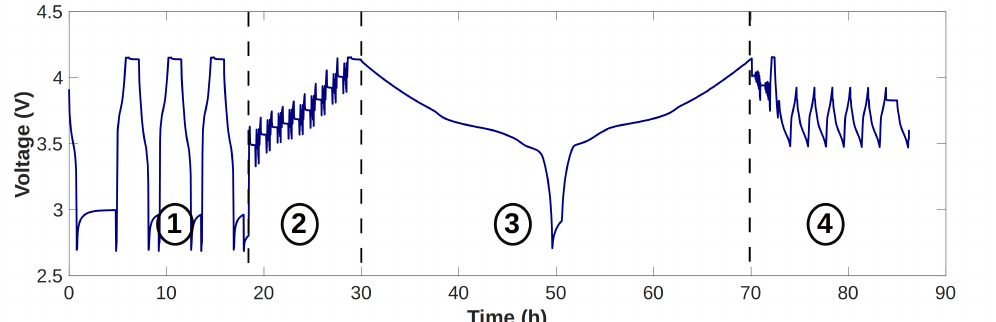
Figure 3. Voltage profile of the test. Step 1 is a capacity test, step 2 is the impedance measurement, step 3 is the low-current measurement and step 4 is the validation cycle.